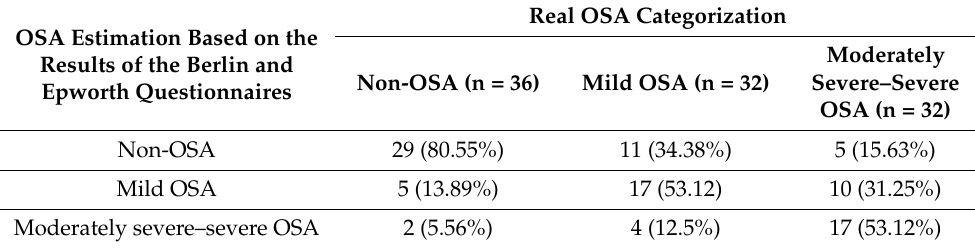
Table 10. OSA prediction based on the joint results of the Berlin and Epworth questionnaires (the table shows the number of cases per 100 patients and the percentage distribution of scores within OSA categories). OSA: obstructive sleep apnoea.